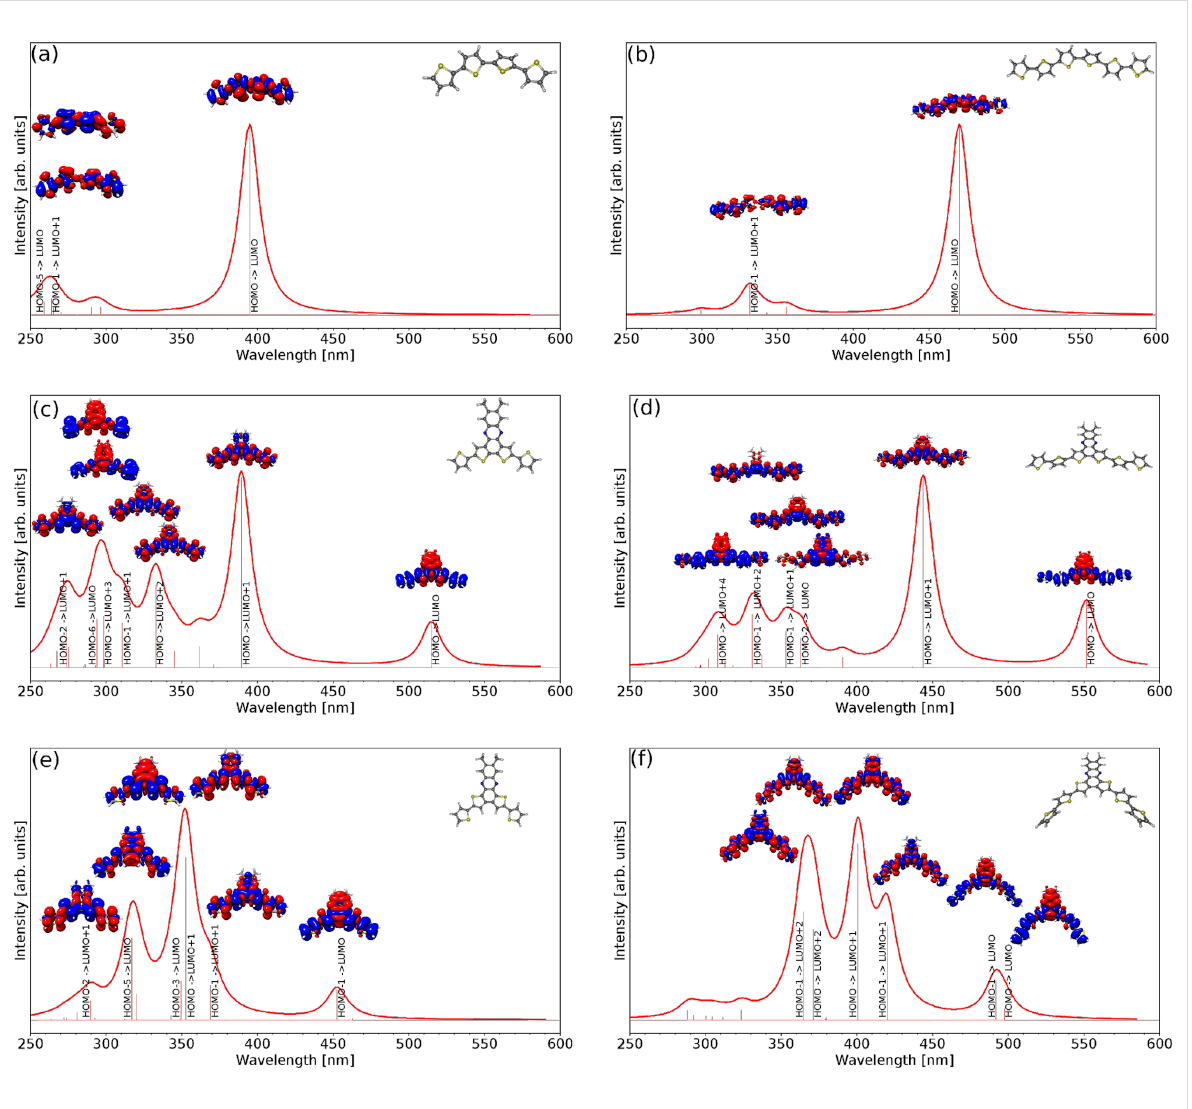
Figure 2: Calculated absorption spectra of (a) 19, (b) 20 , (c) 12a , (d) 13 with R=CH 3 , (e) 16 and (f) 17a . In every spectrum the ground state geometry and the difference densities of the excitations are shown. Blue (red) color indicates a decrease (increase) of electron density after transition from the ground state to the excited state. Absorption signals with large oscillator strengths are labeled with the main excitation inducing the transition to this